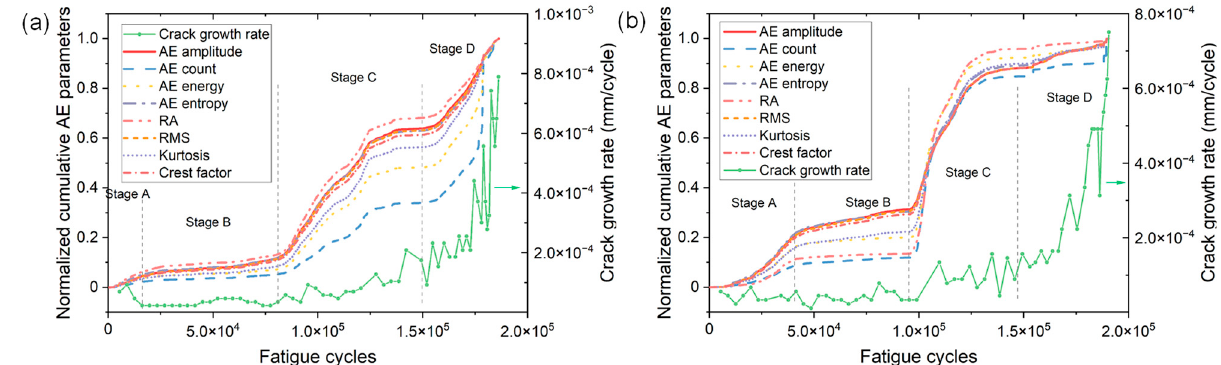
Figure 7. The variations of normalized cumulative AE parameters versus fatigue cycles of ( a ) spec- imen No. 1 and ( b ) specimen No. 2. men No. 1 and ( b ) specimen No.